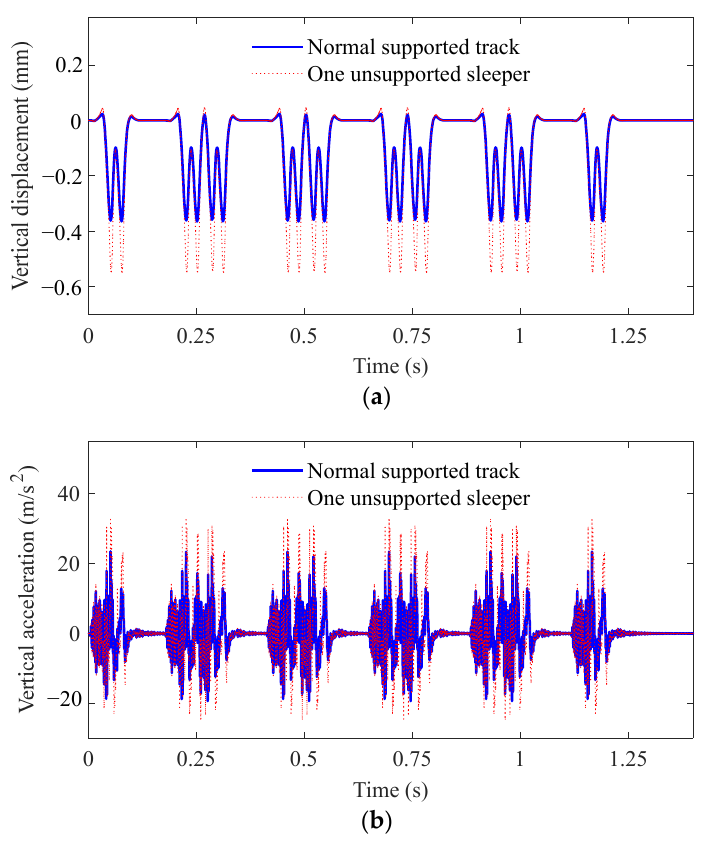
Figure 9. Dynamic responses under the bilateral unsupported sleeper at point A: ( a ) displacement of the track and ( b ) acceleration of the track.